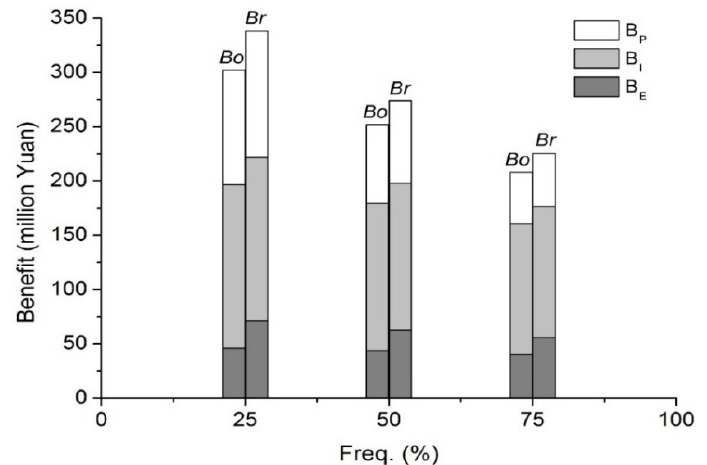
Figure 5. The contrast in benefits between the reservoir routine operation (Bo) and optimal reoperation (Br). B , B and B , respectively, refer to the benefits of power generation, P I E irrigation and water